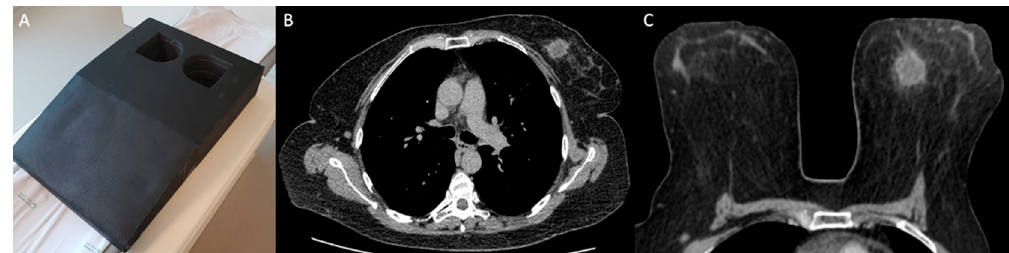
Figure 1. Example of chest multidetector computed tomography (MDCT) with dedicated breast protocol. ( A ) Device used to perform chest MDCT on prone position. ( B ) Axial image of conventional chest MDCT in supine position. ( C ) Axial image of the breast in the same patient using dedicated MDCT protocol in prone position.